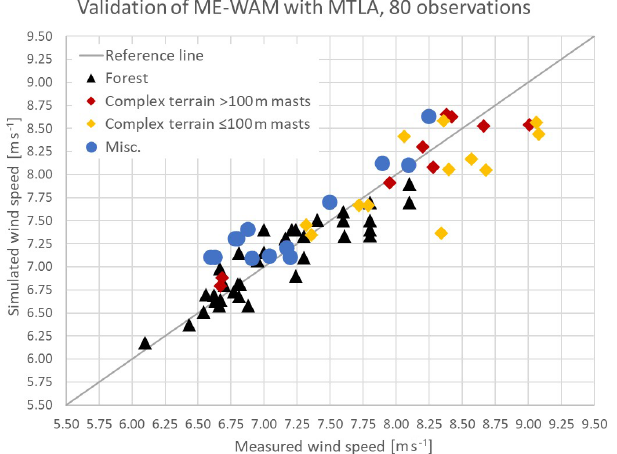
Figure 6. Comparison of simulated wind speed ( y axis) and mea- sured wind speed at the meteorological mast ( x axis) for the 45 data points where MTLA is applied.